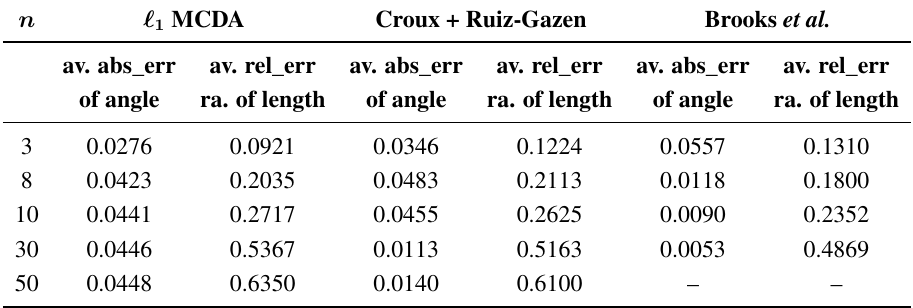
Table 2. The results of (cid:96) MCDA and Robust PCAs on one Student t distribution. 1